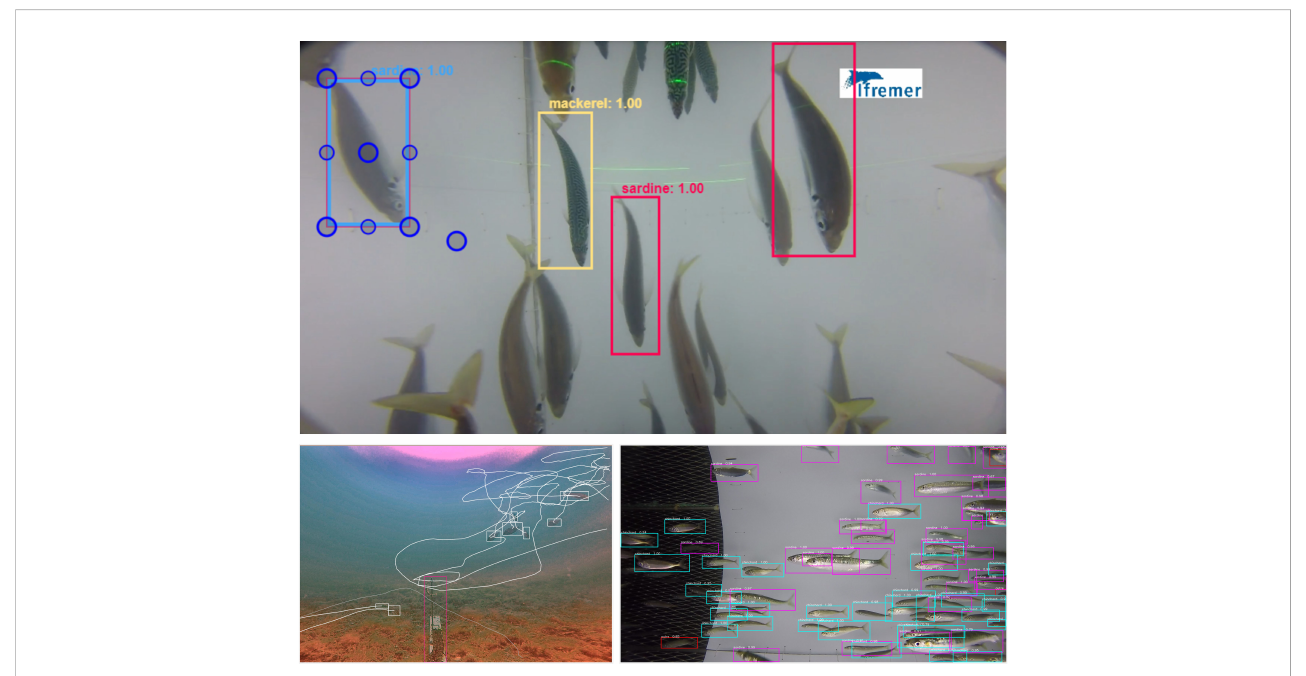
FIGURE 3 Examples of bounding boxes of fi shes. Top panel: Tracking of fi shes on the open-source VIAME platform for image and video analysis (Dawkins et al., 2017). Bottom left: multiple trajectories of black seabreams around a fi xed bait. Bottom right: In situ detections of sardines and horse mackerel inside a gear (Game of Trawls